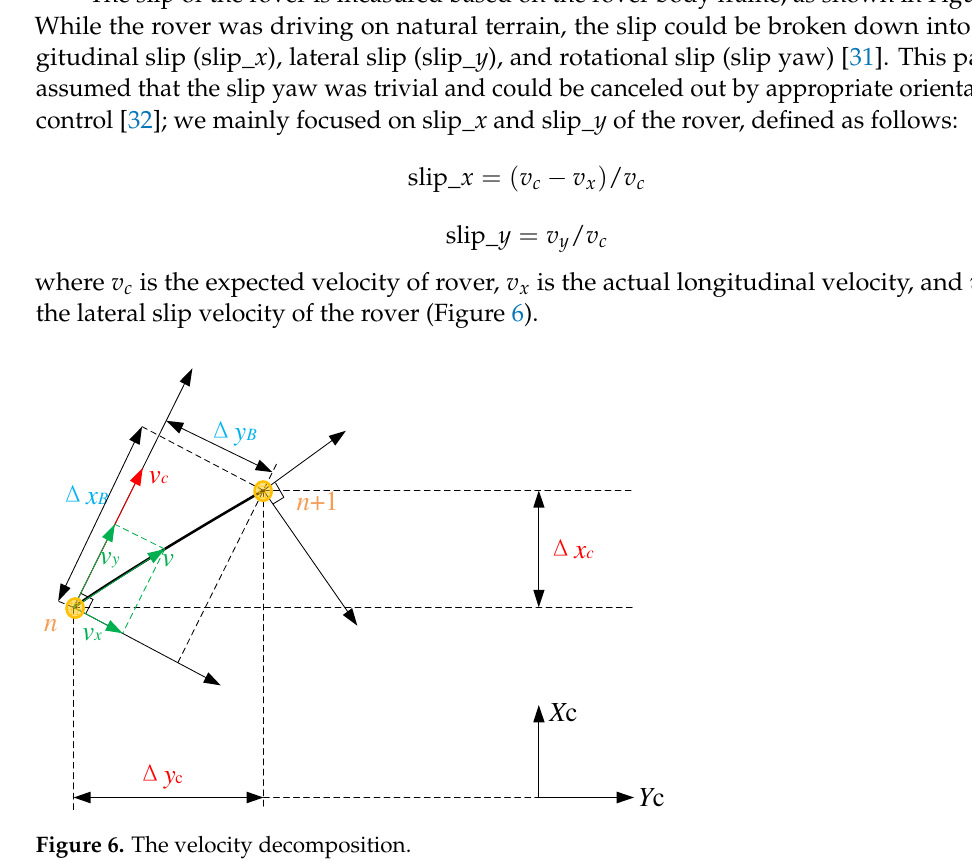
Table 2. The data collected in ground